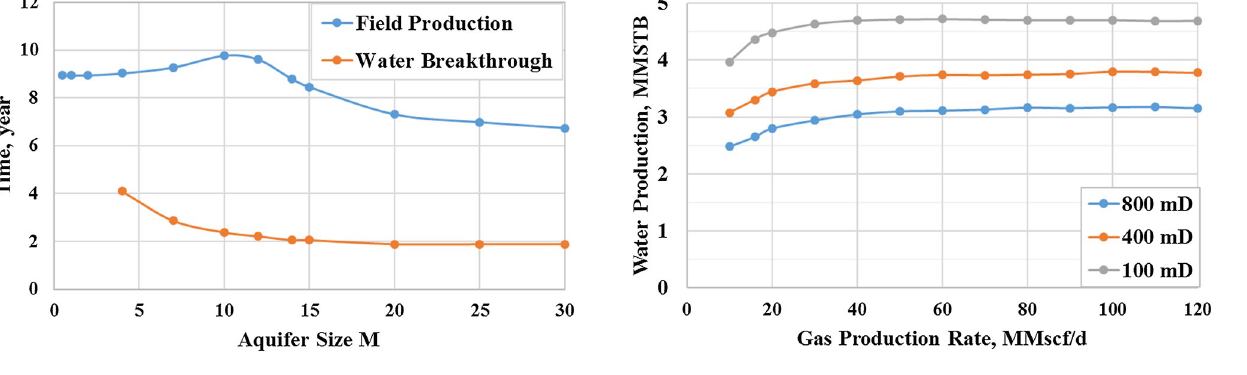
Fig. 29 Field production life and water breakthrough time for differ- ent aquifer sizes